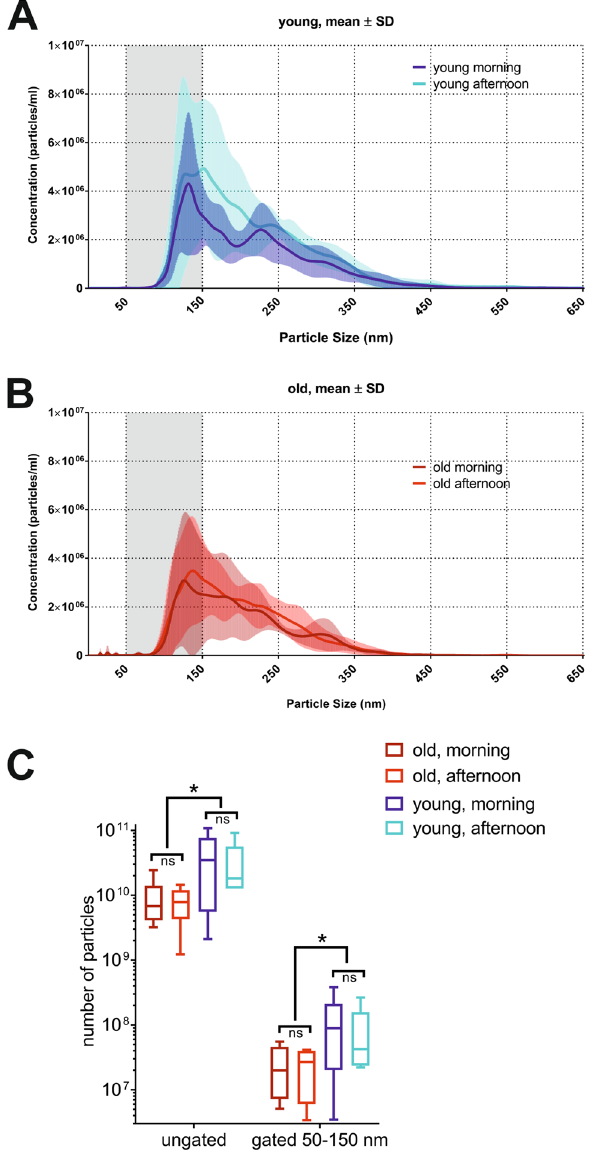
Figure 1. Particle yields of uEVs isolated from two age-matched groups of healthy volunteers at different time-points. uEVs were isolated by UC-SEC (ultracentrifugation followed by size exclusion chromatography) from 37 ml first-void urine (morning) and 37 ml void during the day (afternoon) of two groups of male healthy volunteers (n = 6 per group) without LUT symptoms: “young” (mean age 35 ± 6.6 years old) and “old” (mean age 57 ± 6.1 years old). Samples were eluted in the same volume to allow concentration comparison. (A) Number of uEVs isolated in “young” subjects at two time points of sample collection (morning and afternoon). NTA was performed on isolated uEVs to calculate total particle concentrations (Y-axis). Size distribution graphs show the concentration on Y-axis and size distribution in X-axis. Particles in range of 50–150 nm (shaded area) in the same sample are shown. The results are shown as mean ± SD of 6 samples per each urine collection time point. (B) Number of uEVs isolated in “old” subjects at two time points of sample collection (morning and afternoon). Size distribution graphs show the concentration on Y-axis and size distribution in X-axis. (C) Number of all particles and particles gated for size (between 50–150 nm) in each subjects peak content fraction was counted in “young” and “old” groups. No difference was observed in particle yields (gated and ungated) within an age group regarding collection time (paired, two-tailed t-test). Significant differences between the “young” and the “old” groups were observed in the total particle yields and in the yields of particles gated (50–150 nm) to exosome sizes (* p < 0.05, unpaired, two-tailed